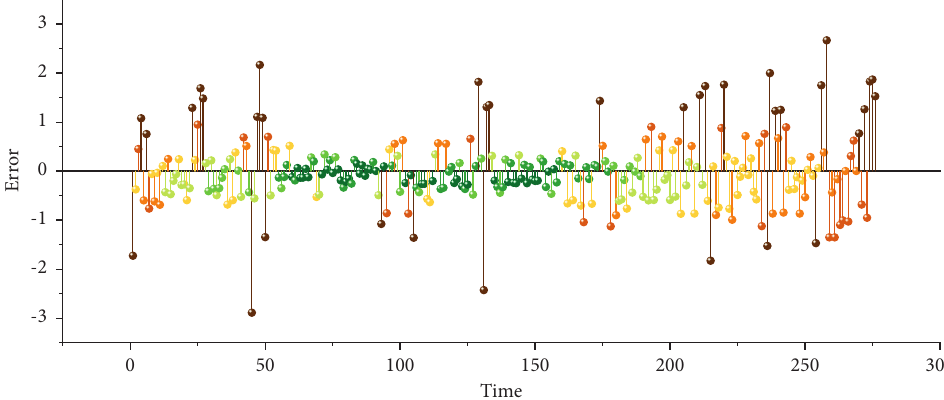
Figure 10: Model prediction error distribution and root mean square